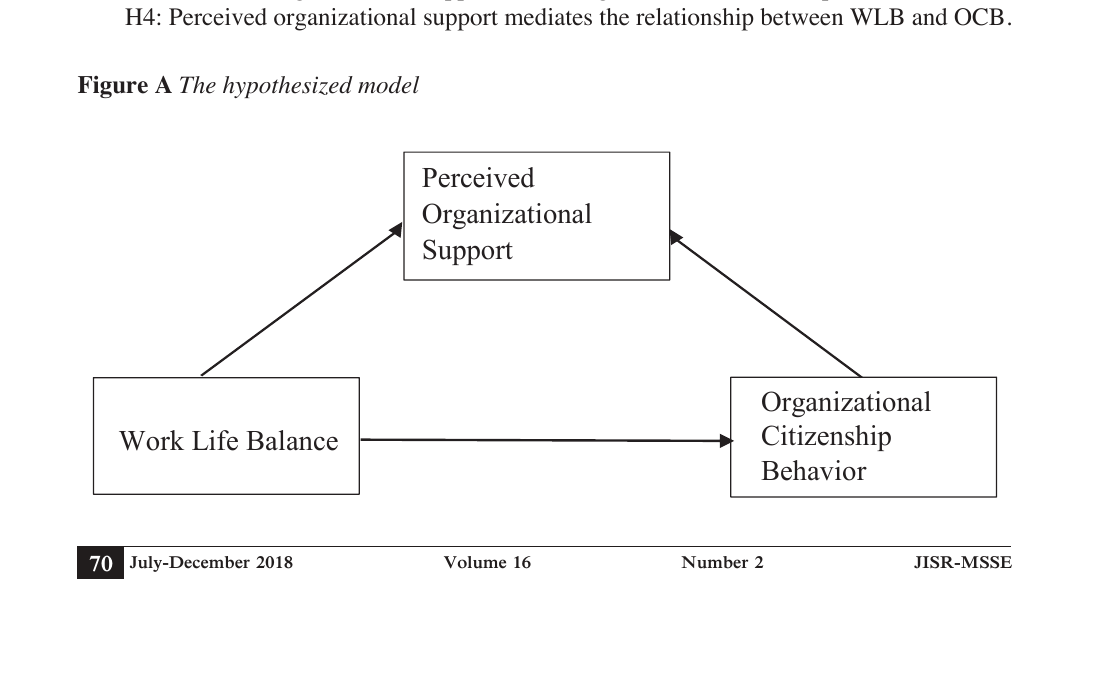
Figure A The hypothesized model